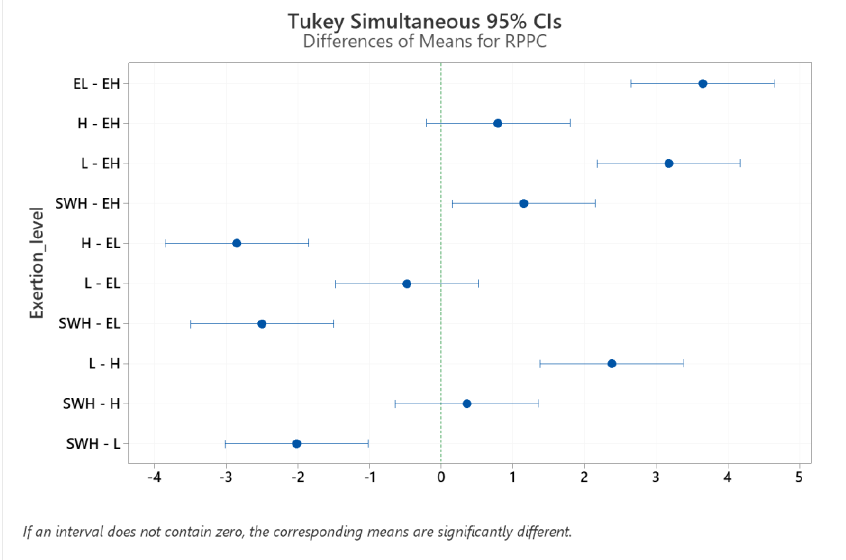
Figure 7. Pairwise comparison between isometric forces at different physical exertion levels to extremely light (EL), light (L), somewhat hard (SWH), hard (H), and extremely hard (EH). CI: confidence